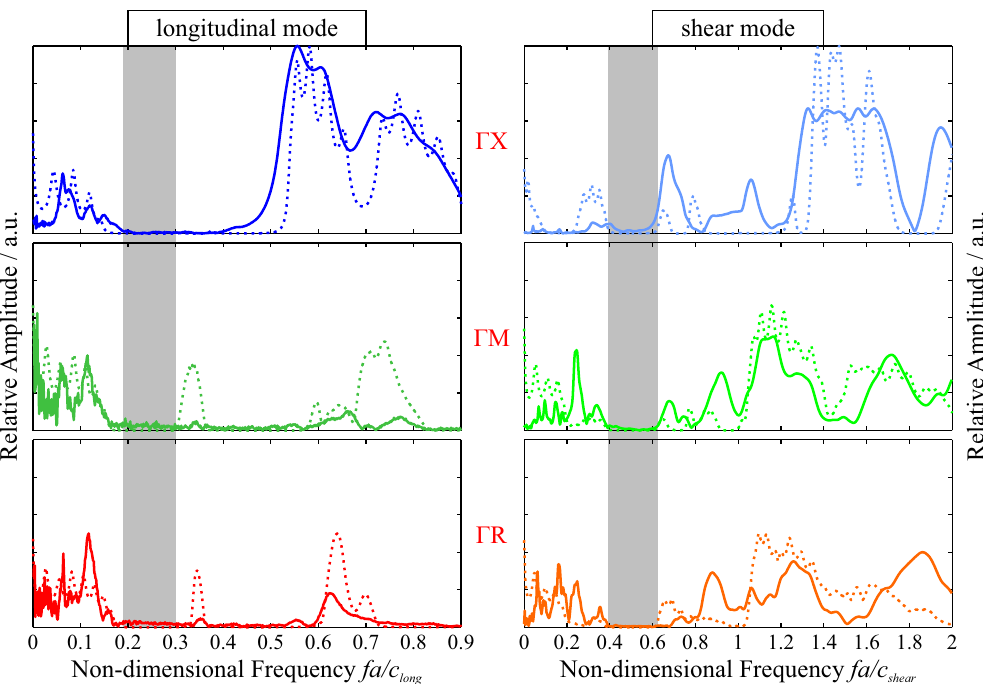
Figure 11. Normalized acoustic transmission for corner ball design Figure 1c in characteristic directions Γ X, Γ M, and Γ R for longitudinal waves [31] and shear waves. Dotted lines indicate simulated transmission through a semi-infinite lattice, and shaded areas indicate the regions of the complete band gap of an infinite